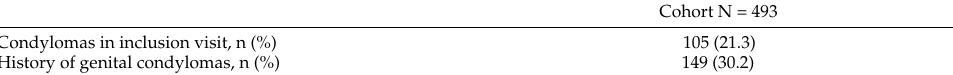
Cohort N = 493 105 (21.3) 149 (30.2)